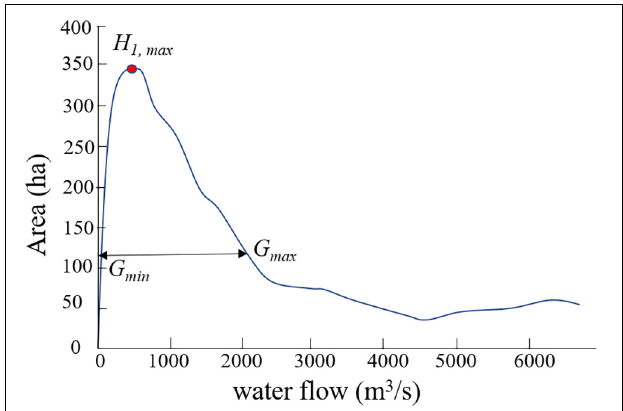
FIGURE 3 | The flow – habitat area curve of the indicator species in growing